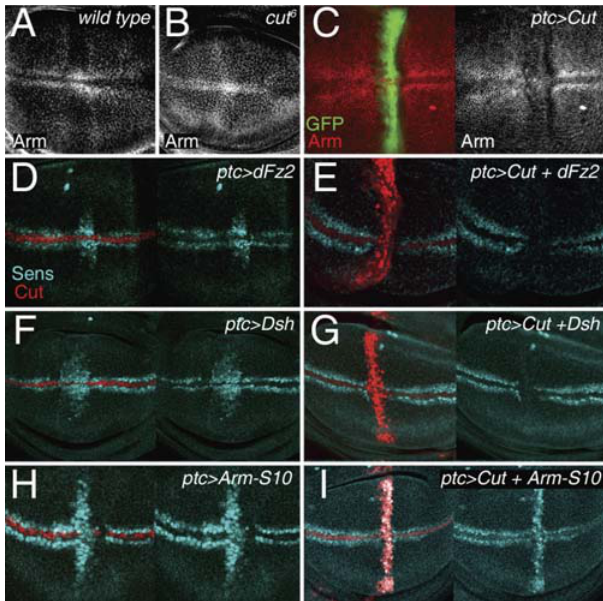
Figure 5. Cut blocks the Wg pathway at the level or upstream of Armadillo. (A–C) Mature wild-type (A), cut 6 (B) and dpp Gal4 ; UAS-Cut UAS- GFP (C) wing discs labeled to visualize Armadillo (Arm) protein expression levels (in white or red) and GFP (in green). (D–I) Mature wing discs that expressed dFz2 (D), Dsh (F), Arm S10 (H), dFz2 and Cut (E), Dsh and Cut (G), or Arm S10 and Cut (I) under the control of the ptc Gal4 driver and labeled to visualize Senseless (Sens) protein expression levels (in blue) and Cut (in red). doi:10.1371/journal.pone.0000602.g005 levels and represses the expression of Wg target genes (Figure 5C and 4D, respectively). Moreover, Arm S10 can bypass the effects of ectopic Cut expression and restores Wg target gene expression in non- boundary cells (Figure 5I). Co-expression of limiting factors of the Wg pathway acting upstream of Arm does not cause this effect (Figures 5E and 5G). Taken together, these results indicate that Cut